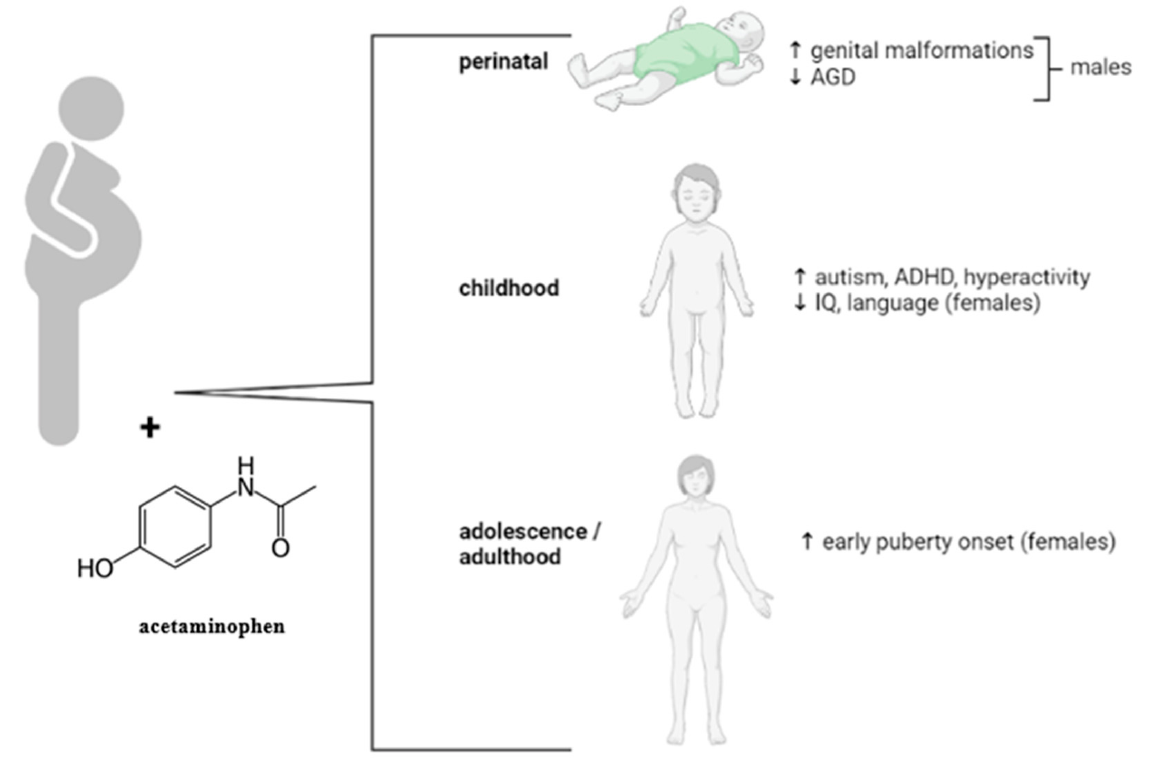
Figure 3. Acetaminophen exposure in potential pregnancy-associated effects observed in human studies. ( ↑ —increase, ↓ —decrease)